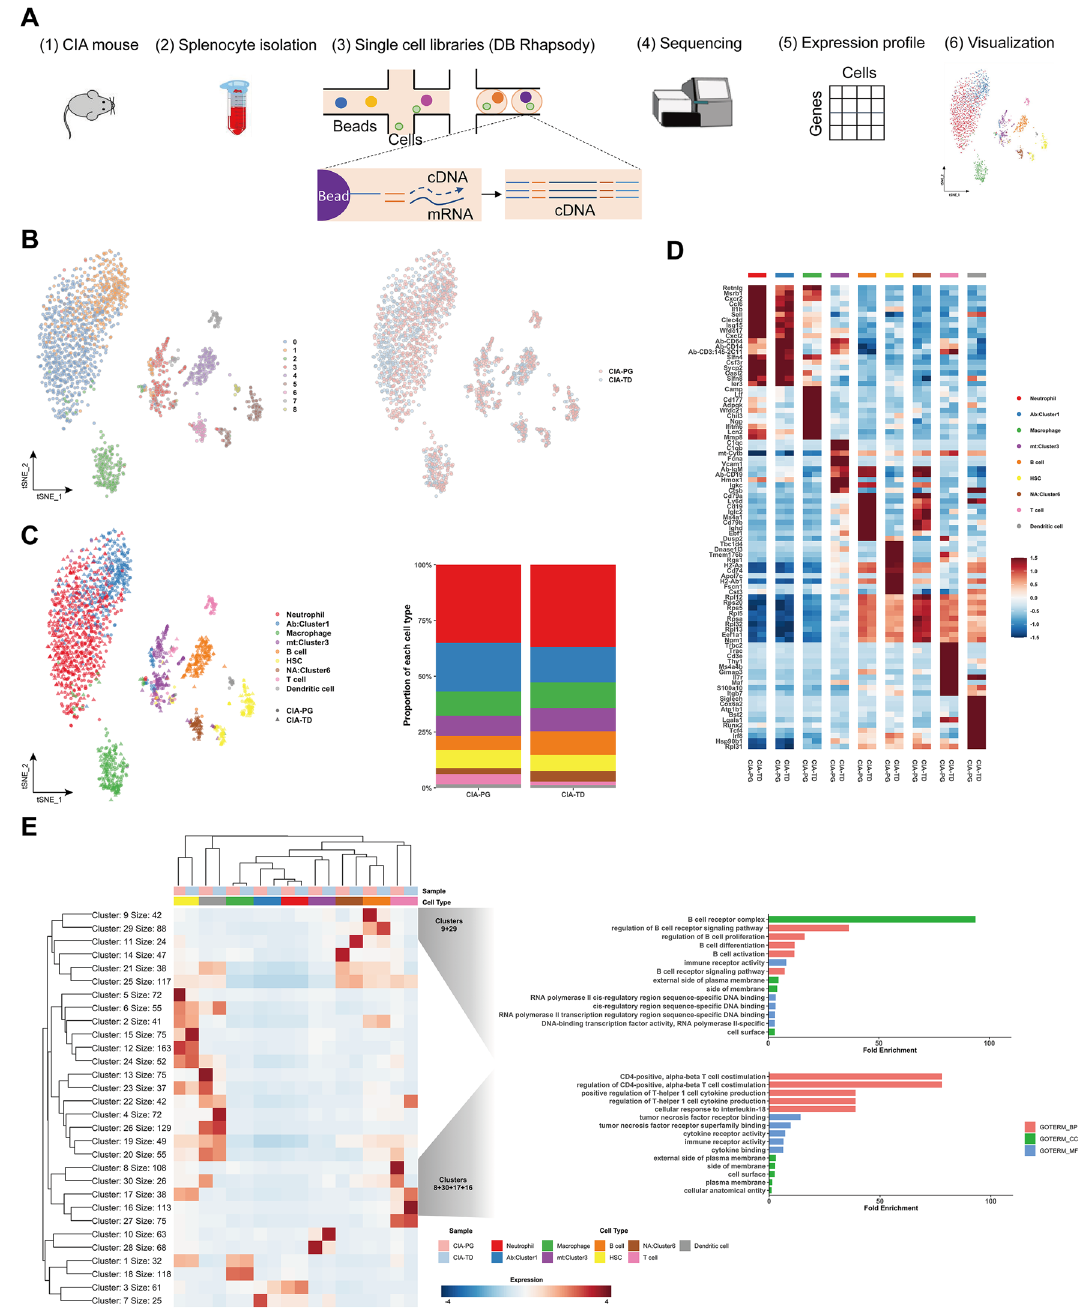
Figure 4. Identification of cell populations and differential gene expression patterns in CIA mice inoculated with different species of periodontal bacteria. ( A ) Schematic illustration of single-cell transcriptome experiments, from splenocyte collection to visualization. ( B ) t-Distributed stochastic neighbour embedding (tSNE) plots of single cells colored by the major cell lineages (left panel) and by the mouse type, CIA-PG or CIA-TD (right panel). ( C ) Identification and proportion of each cell type in the CIA-PG and CIA-TD models visualized by tSNE and bar plots. ( D ) Heatmap of gene expression levels of the 10 most significant genes per cell type clusters. ( E ) Heatmap of K-means clustering of differentially expressed genes (DEGs) and subsequent gene ontology (GO) enrichment analysis. DEGs were clustered into 30 groups (K = 30, the model-based optimal number; left panel). The most differentially enriched GO categories according to the biological process, cellular component, and molecular function are shown for selected clusters in B and T cell populations (right panel). CIA-PG, P. gingivalis exposed CIA mice; CIA-TD, T. denticola exposed CIA mice; BP, biological process; CC, cellular component; MF, molecular